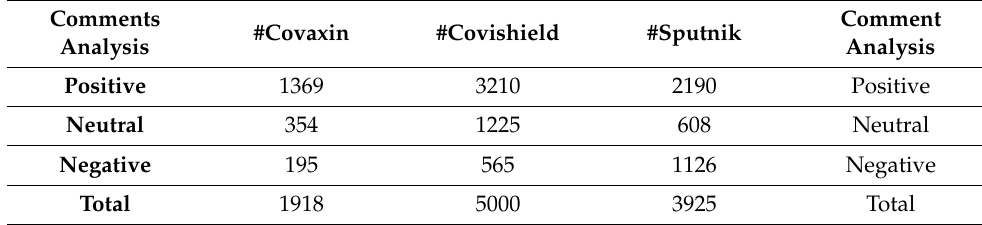
Table 2. Experimental findings of sentiment polarization for different hashtags after